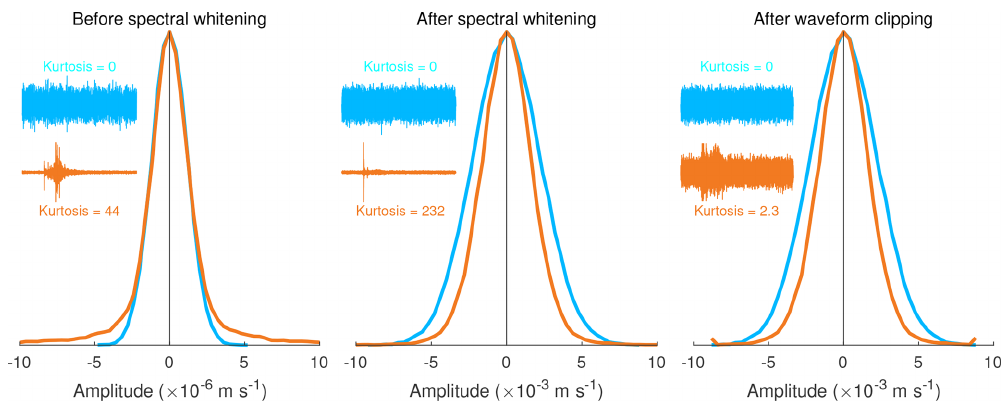
Figure 3. Kurtosis-based selection filter to determine if a segment contains large-amplitude transients. The two segments used here are the same as in Fig. 2. For display, waveforms are plotted at varying scales. The amplitude histograms are normalized by their own maximums. Histogram tails outside the horizontal axis limits are